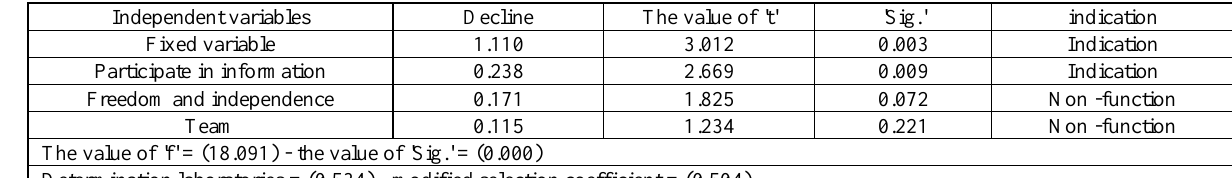
Table 21. Person's correlation transactions between the team and strategic goals Independent variables Decline The value of 't' 'Sig.' indication Fixed variable 1.110 3.012 0.003 Indication Participate in information 0.238 2.669 0.009 Indication Freedom and independence 0.171 1.825 0.072 Non -function Team